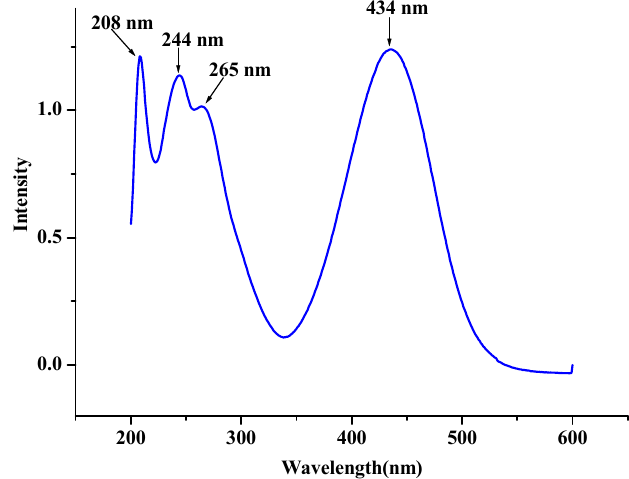
Figure 3. Electronic absorption spectra of the title compound measured in EtOH